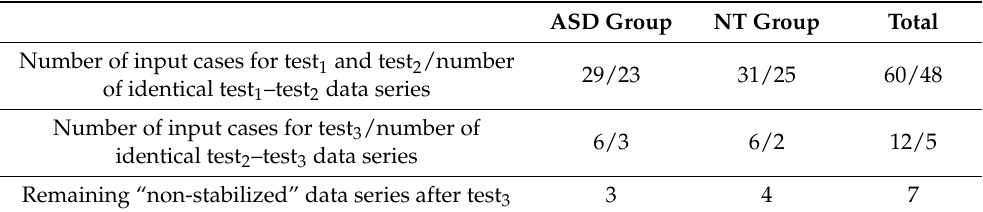
Remaining “non-stabilized” data series after test